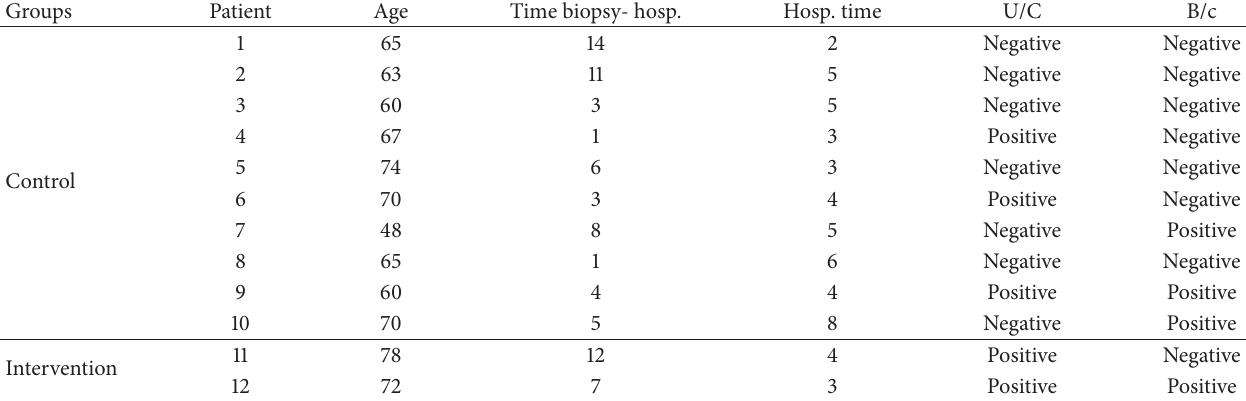
Table 3: Characteristics of patients with infection after biopsy in control and intervention groups.